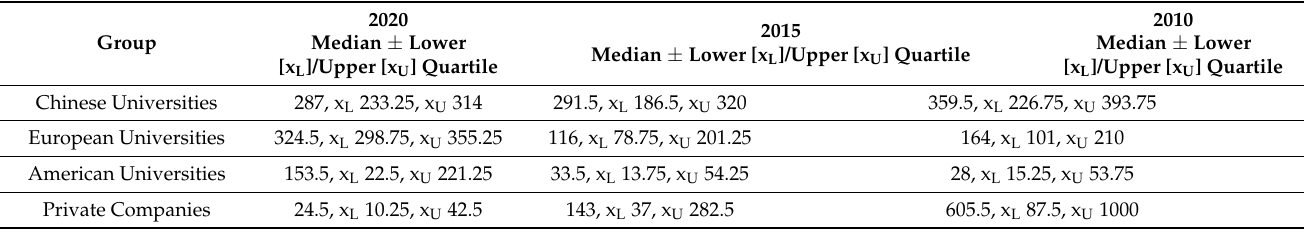
Figure 3. Trends 2010–2020 in sub indicator “Innovation” in the best 30 universities of China, the European Union, the US, and in private companies. Table 5. Trends 2010–2020 between groups in sub indicator “Innovation” in the best 30 universities of China, the European Union, the US, and in private companies.